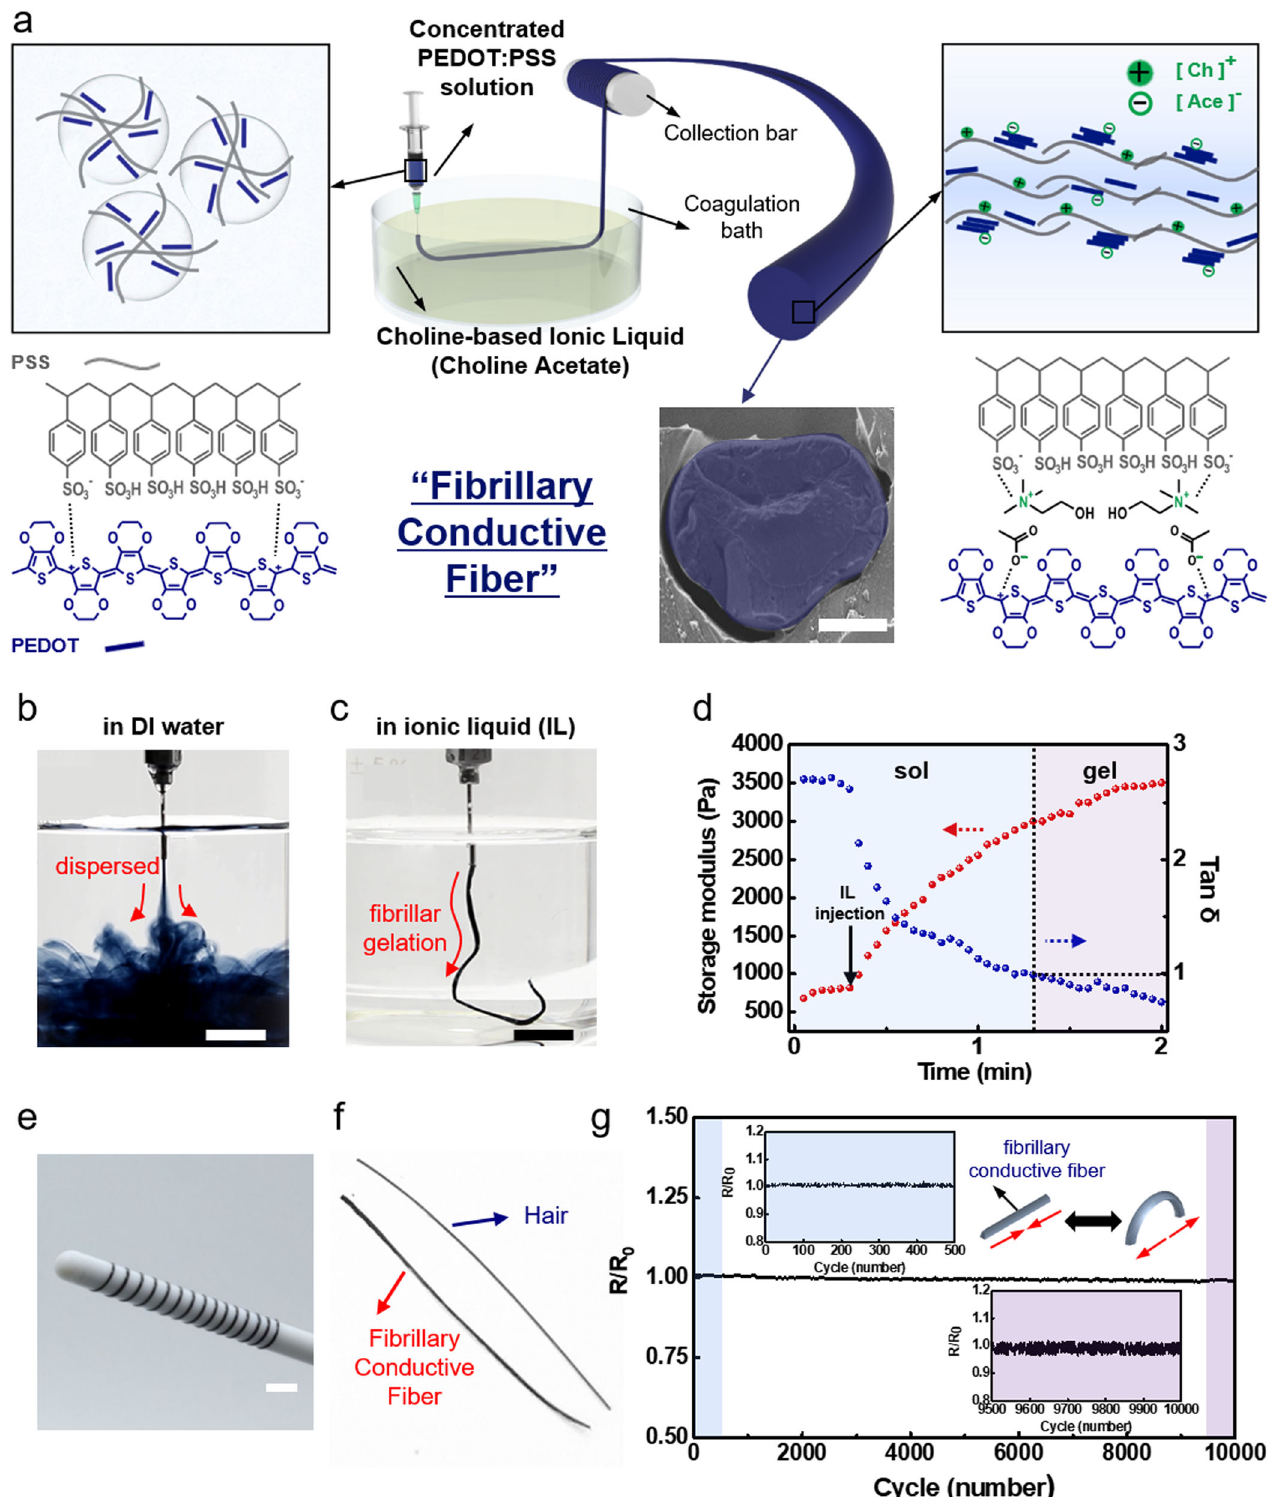
Fig. 1 Fibrillary gelation for a conductive fi ber. a Scheme of fabrication of conductive fi ber by fi brillary gelation at interface between PEDOT: PSS solution and choline-based ionic liquid, and cross-sectional SEM image of the fi ber (highlighted navy, scale bar: 100 μ m). Photo images for re-dispersed concentrated PEDOT:PSS solution in DI water ( b ) and fi brillary gelation in choline acetate ( c ), which proves that increasing ionic strength can lead to gelation of PEDOT:PSS (scale bar: 1 cm). d Gelation process that occurs by injecting choline-based ionic liquid ([Ch][Ace]) into PEDOT:PSS. When the Tan δ value becomes 1, sol changes to gel. e Image of the PEDOT:PSS conductive gel fi ber collected on a Te fl on bar. f Conductive fi ber after thermal annealing (scale bar: 1 mm) compared to a human hair. g Resistance change (R/R 0 ) of a single conductive fi ber during 10,000 cycles of bending (curvature, r − 1 = 0.6 mm − 1 ). Insets shows schematic image of bending test and their signal comparisons with initial and fi nal